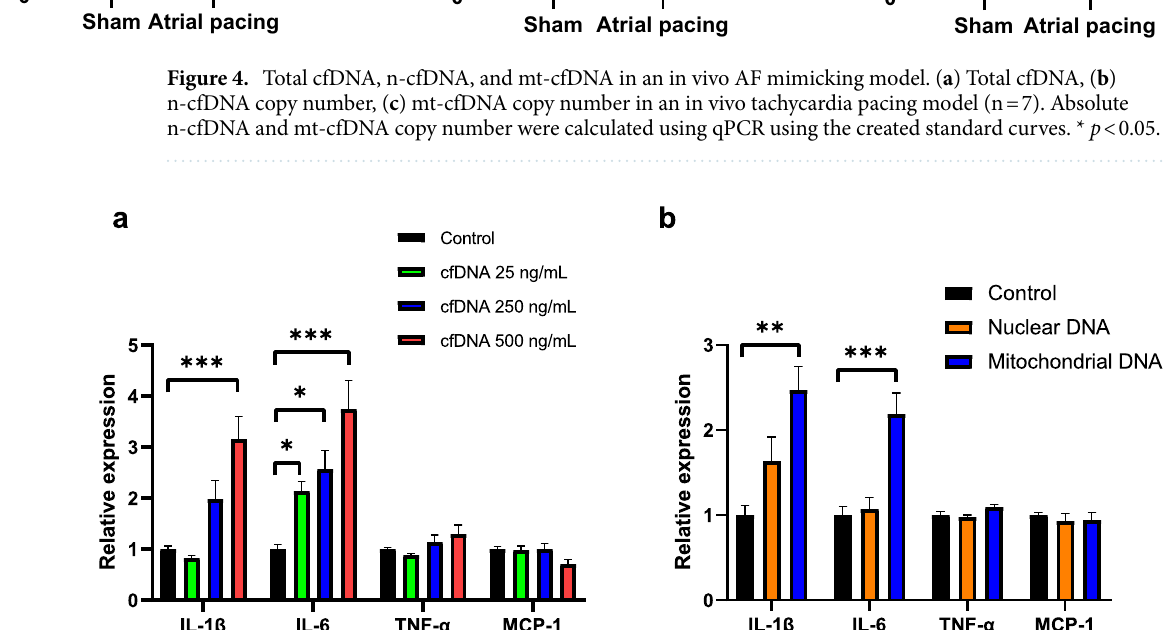
Figure 5. mt-cfDNA, but not n-cfDNA, promoted IL-1β and IL-6 expression in macrophages. ( a ) Total cfDNA (25 ng/mL, 250 ng/mL or 500 ng/mL) (n = 4–8), ( b ) n-cfDNA (500 ng/mL), and mt-cfDNA (500 ng/mL) (n = 5–8) were applied to J774.1, then pro-inflammatory cytokines expression was analyzed using qPCR. Nuclear and mitochondrial DNA were independently extracted and fragmented to simulate n-cfDNA and